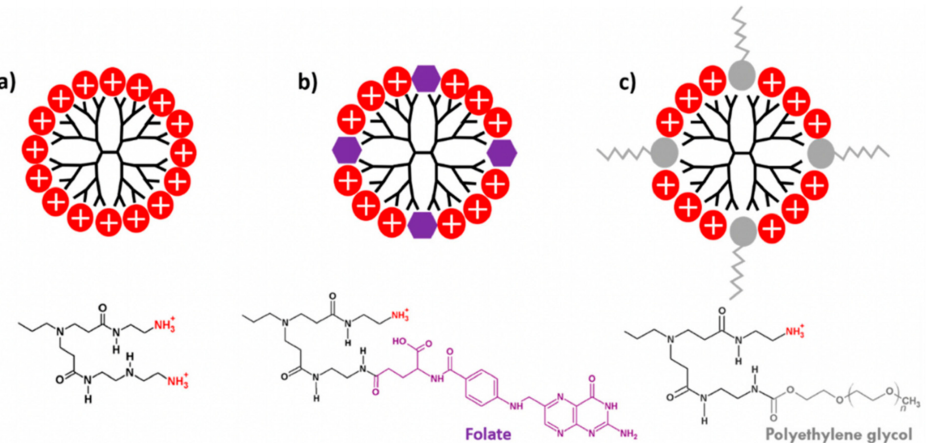
Scheme 5. Schematic representation of G4-PAMAM functionalized with polyethylene glycol (PEG), and folate terminal groups: ( a ) G4-PAMAM dendrimer with positively charged superficial groups; ( b ) G4-PAMAM dendrimer functionalized 25% folate end-groups, and ( c ) G4-PAMAM dendrimer functionalized 25% PEG on the surface. This scheme was provided thanks to Reference